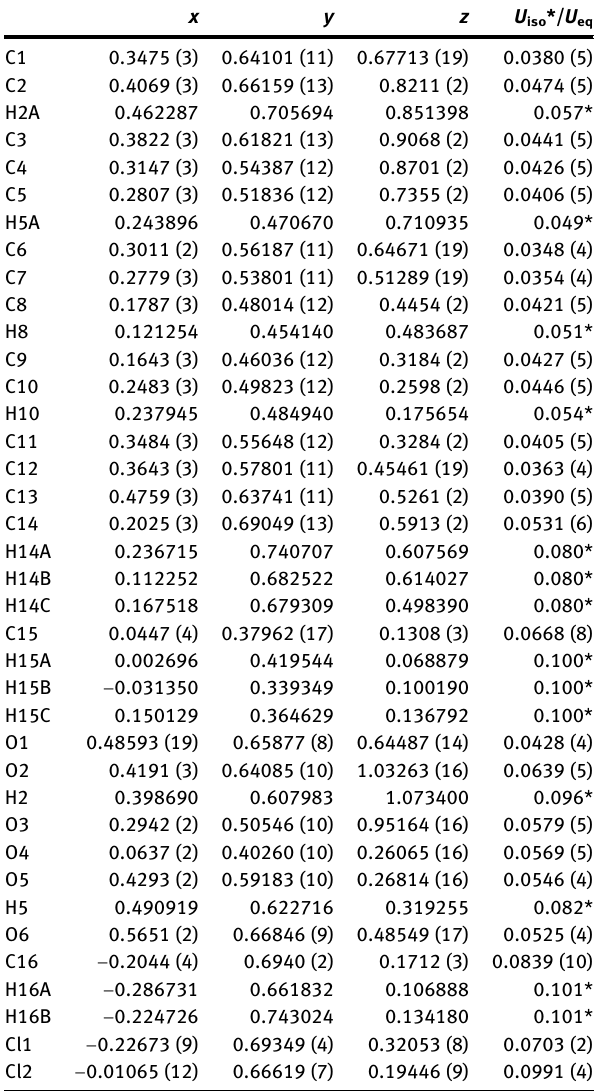
Table  : Fractional atomic coordinates and isotropic or equivalent isotropic displacement parameters (Å 